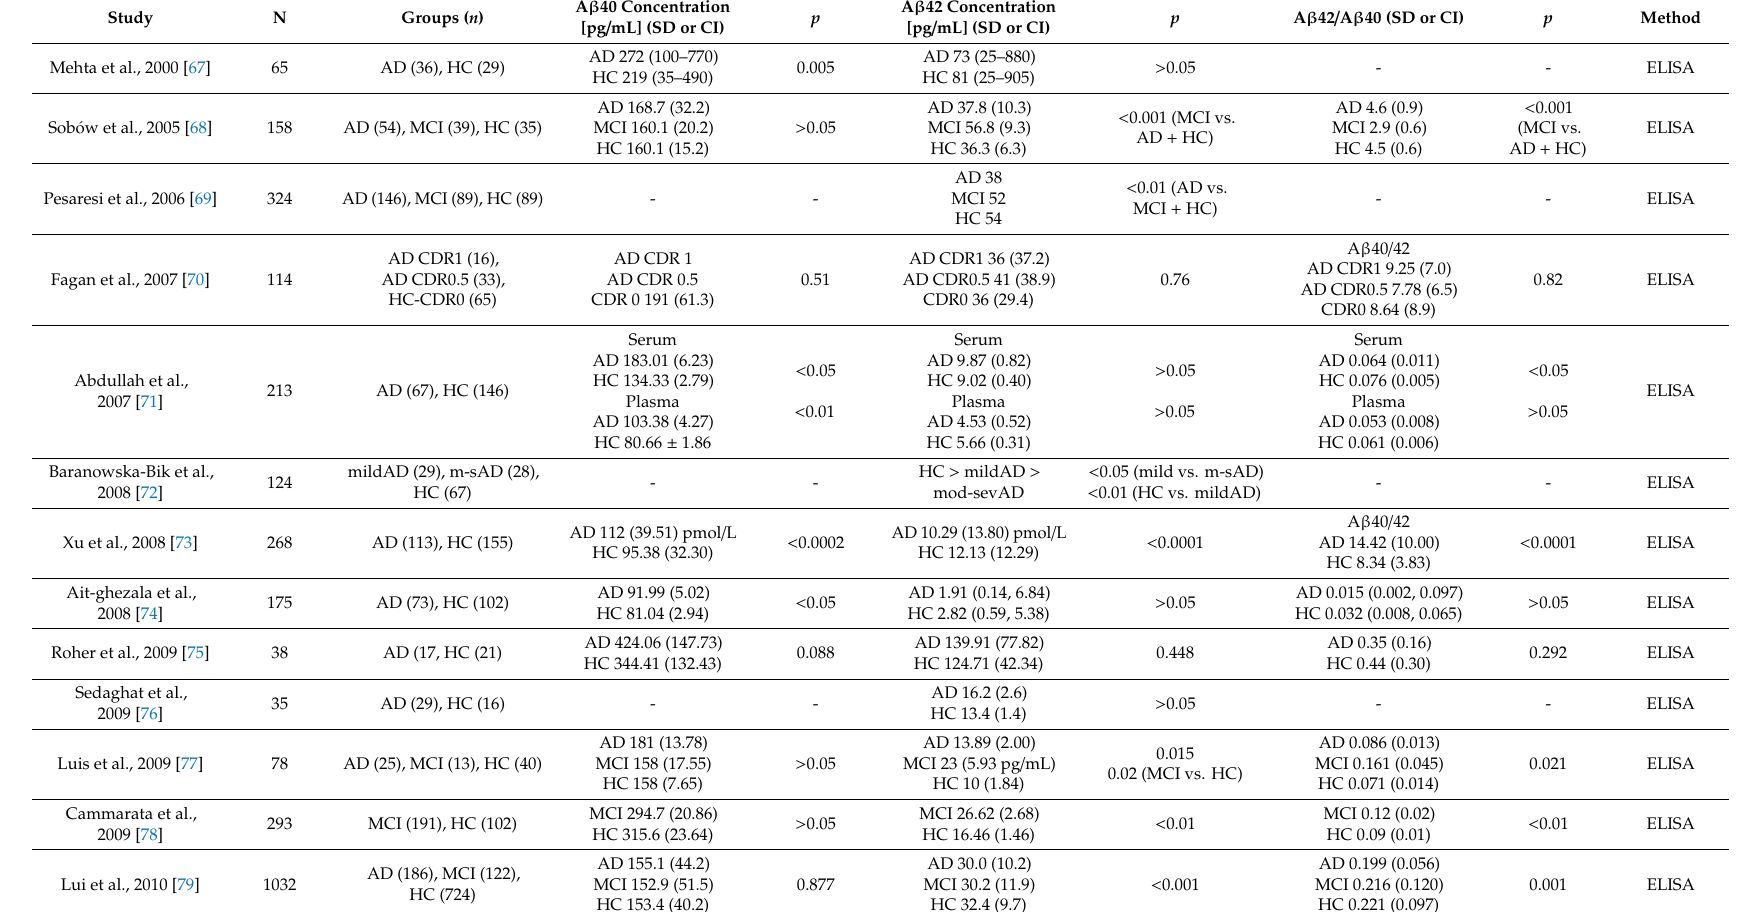
Table 2. Studies on A β 40, A β 42, and A β 40 / A β 42 in